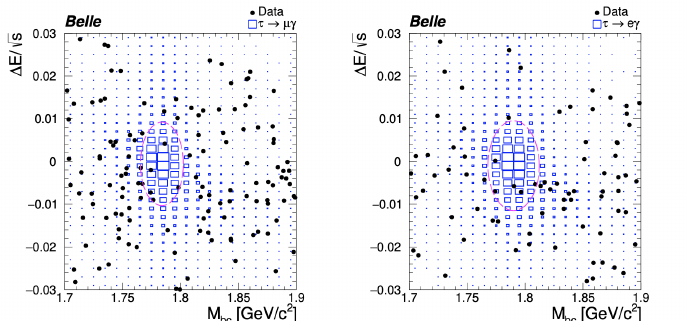
√ s vs. M BC for τ ± → µ ± γ ( left ) and τ ± → e ± γ ) Figure 22. Two-dimensional distributions of ∆ E / ( right ) events. Black points are data, blue squares are τ ± → l ± γ signal MC events, and magenta ellipses show the ± 2 σ signal regions used in this analysis (Figure and caption from